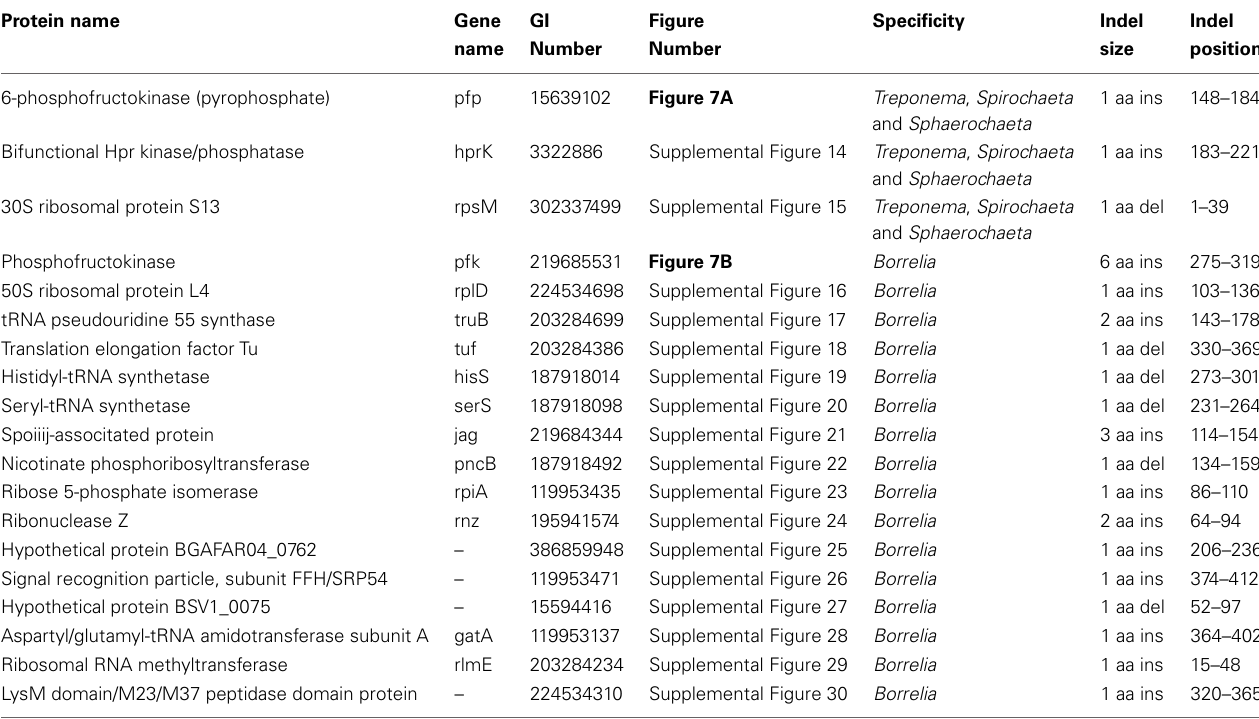
Table 5 | Conserved Signature Indels that are specific for groups within the family Spirochaetaceae